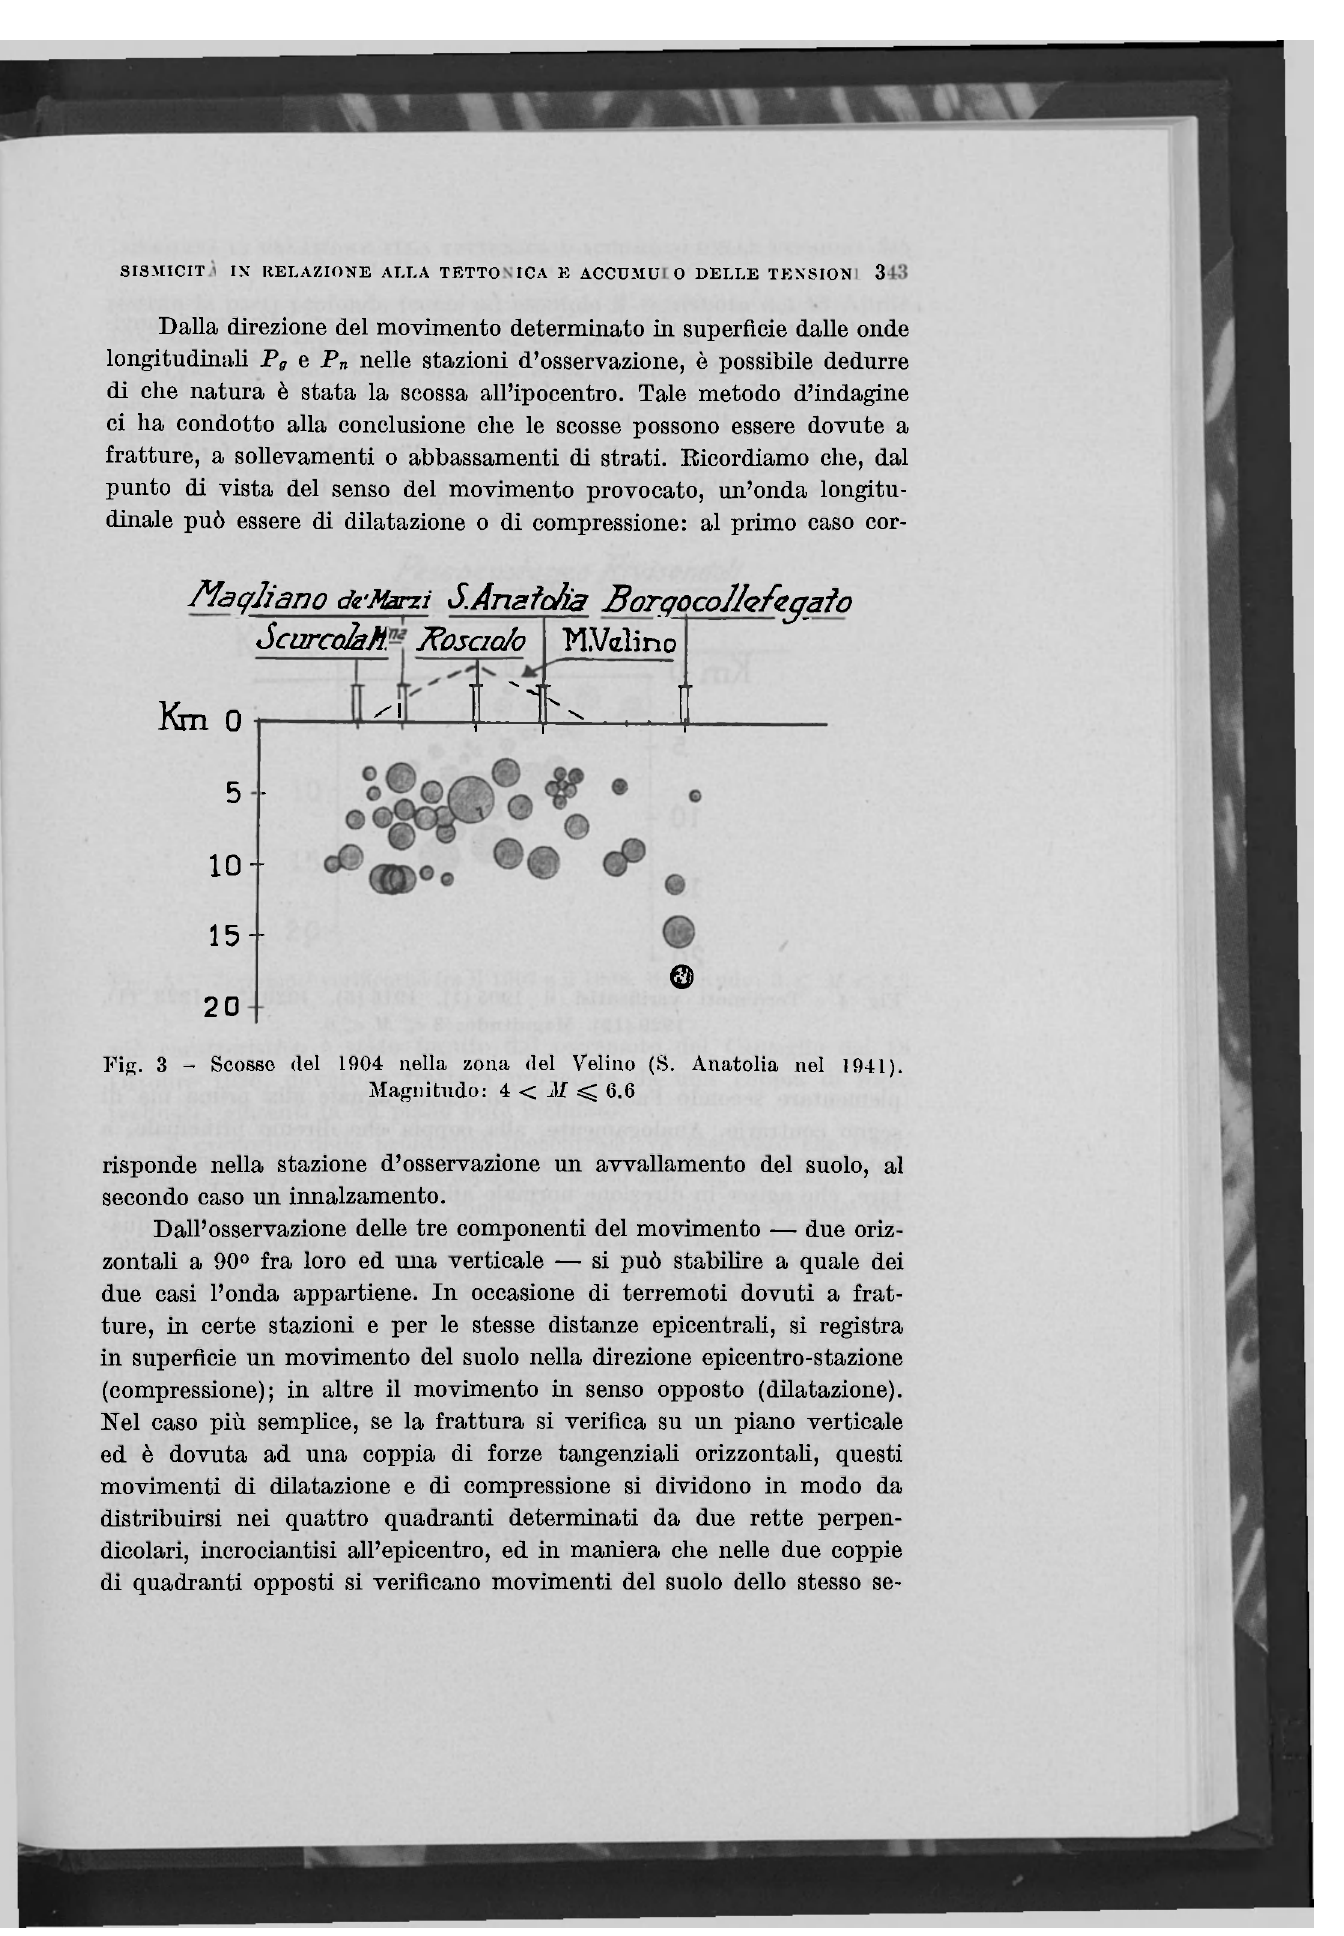
Fig. 3 - Scosse del 1904 nella zona del Velino (S. Anatolia nel 1941). Magnitudo: 4 < ili <